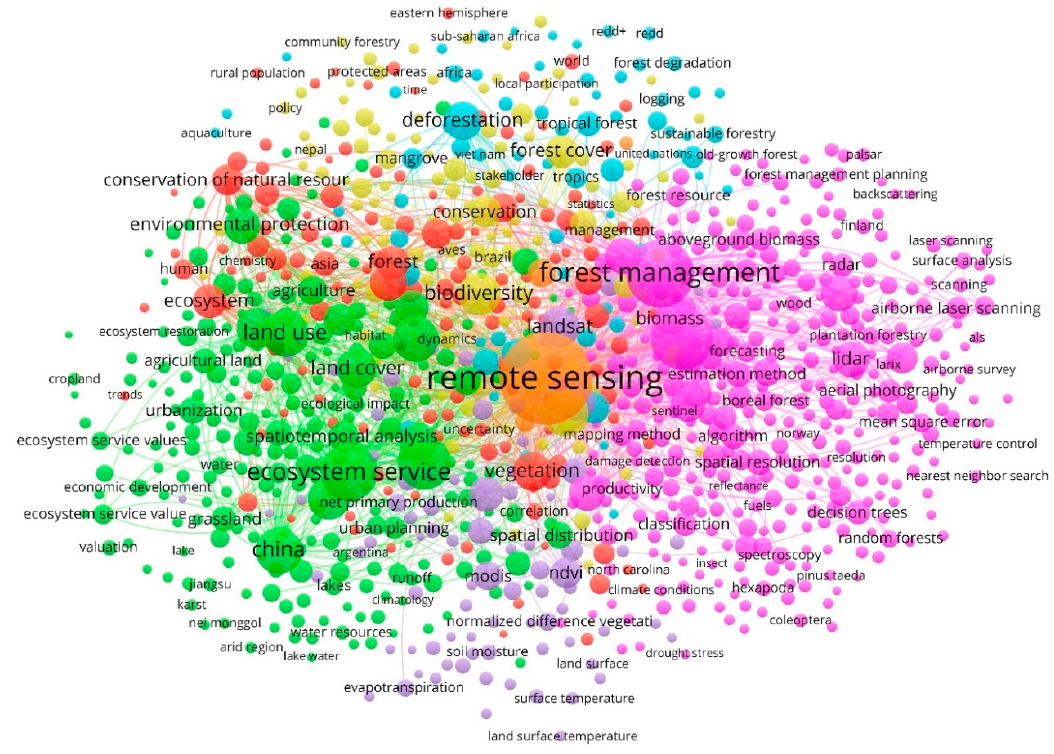
Figure 4. Network of keywords based on co-occurrence method (1976–2019).